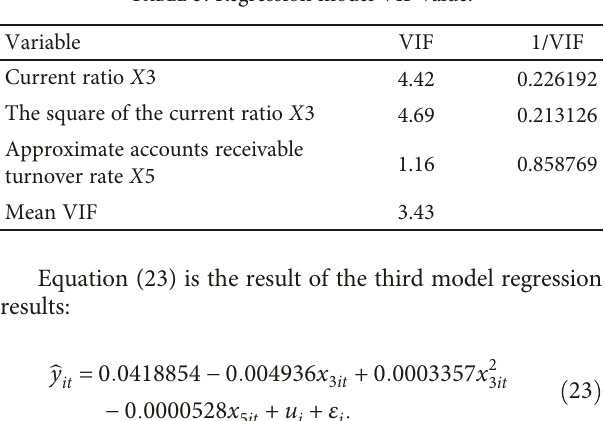
Table 3: Regression model VIF value.